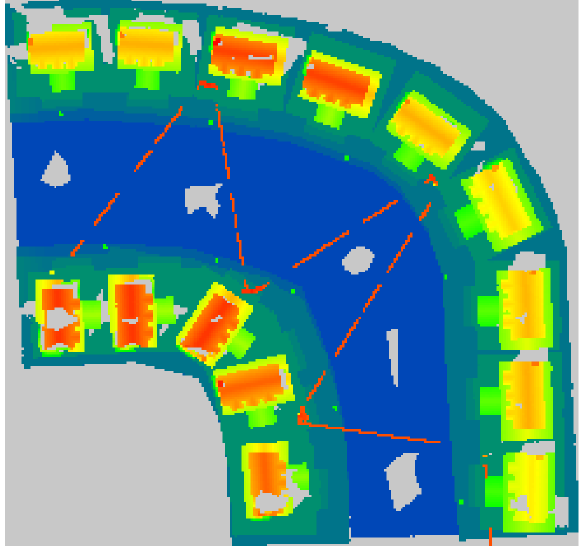
Figure 2. The data structures used for the point cloud processing and the holes